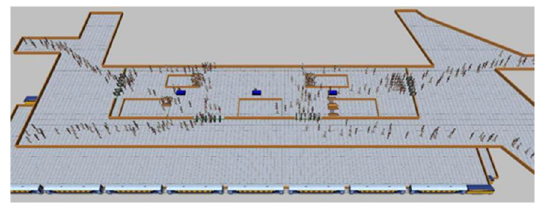
Figure 14. Pedestrian distribution in 3D view at 60 s.